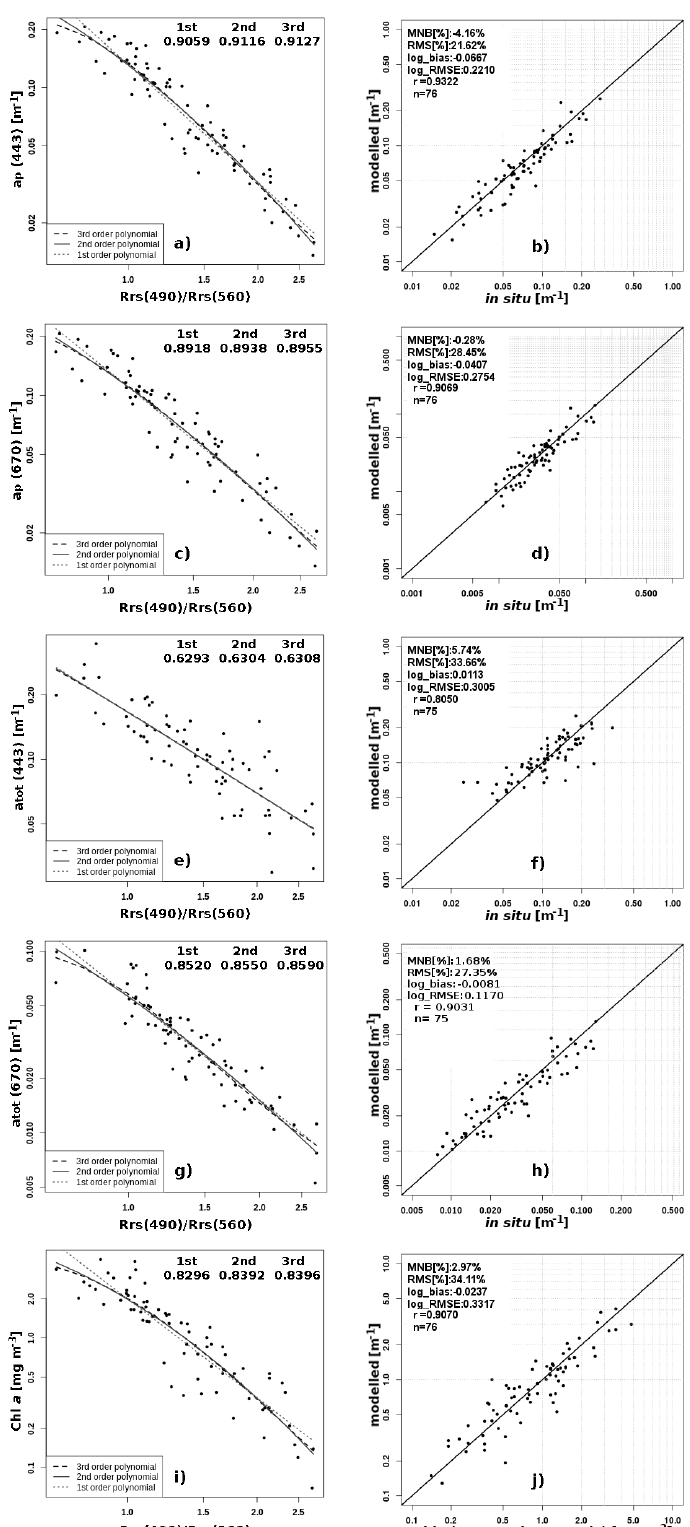
Figure 7. Regression lines fitted on the basis of development datasets (left) and scatterplots of modelled values against reference datasets of in situ measurements (right). Absorption by particles at 443 nm ( a , b ), absorption by particles at 670 nm ( c , d ), total absorption at 443 nm ( e , f ), total absorption at 670 nm ( g , h ), chlorophyll a concentration ( i , j ). Predictions based on simulated OLCI